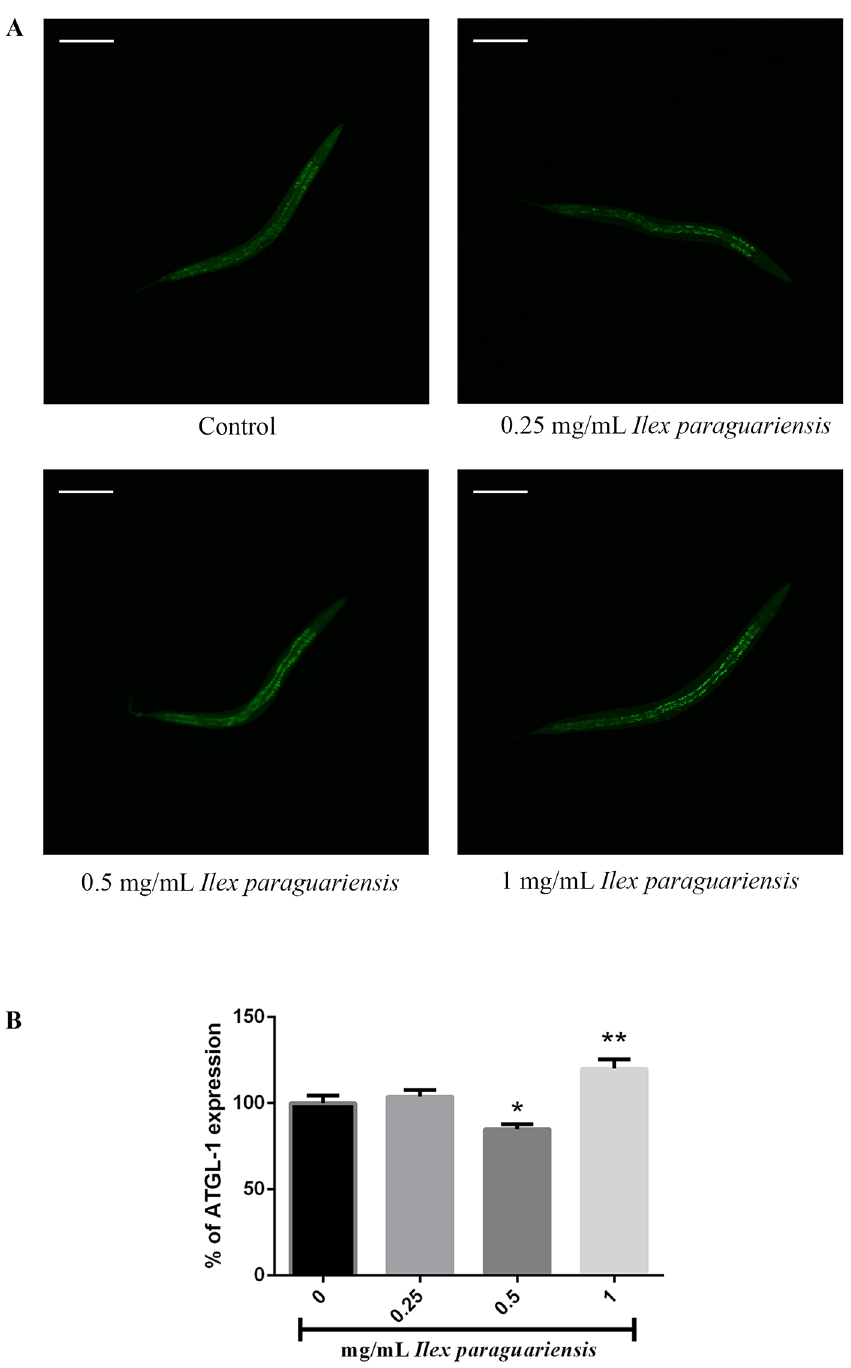
Fig 1. Ilex paraguariensis effects on ATGL-1::GFP expression in Caenorhabditiselegans VS20 strain. (A) Visualization of ATGL-1::GFP expression and (B) measurement of ATGL-1::GFP expression on young-adult Caenorhabditis elegans . (cid:3) p < 0.05 and (cid:3)(cid:3) p < 0.01, statistically significant compared with the untreated group by One- Way ANOVA followed by Bonferroni post-test (mean, standard error of the mean [SEM], n = 30 worms per group). The experiments were performed in